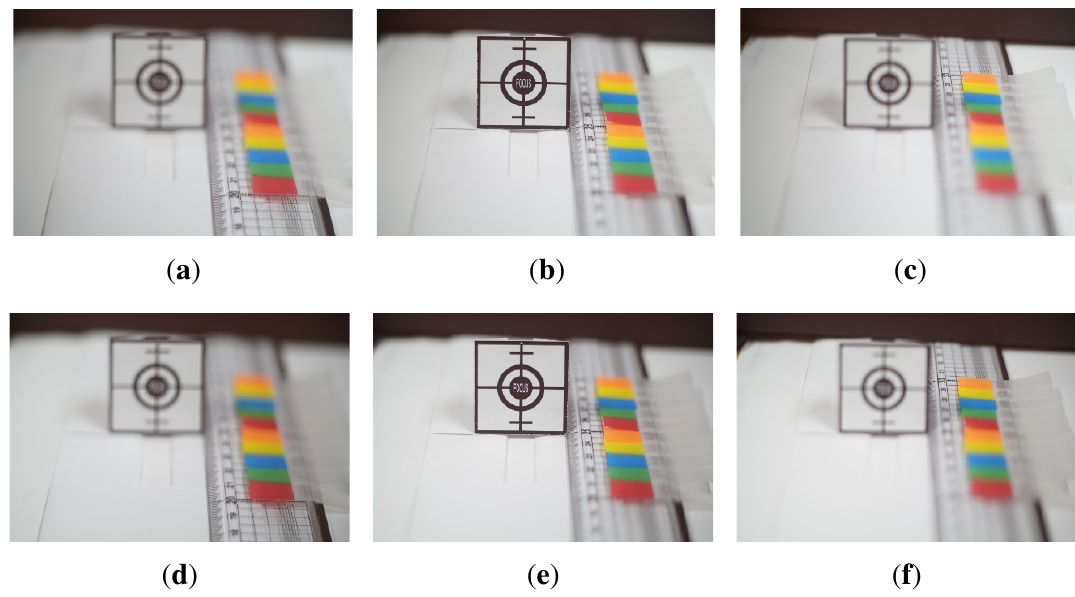
Figure 9. The set of differently-focused test images: ( a ) left-phase, front-focus image; ( b ) left-phase, in-focus image; ( c ) left-phase, far-focus image; ( d ) right-phase, front-focus image; ( e ) right-phase, in-focus image; end ( f ) right-phase, far-focus image.